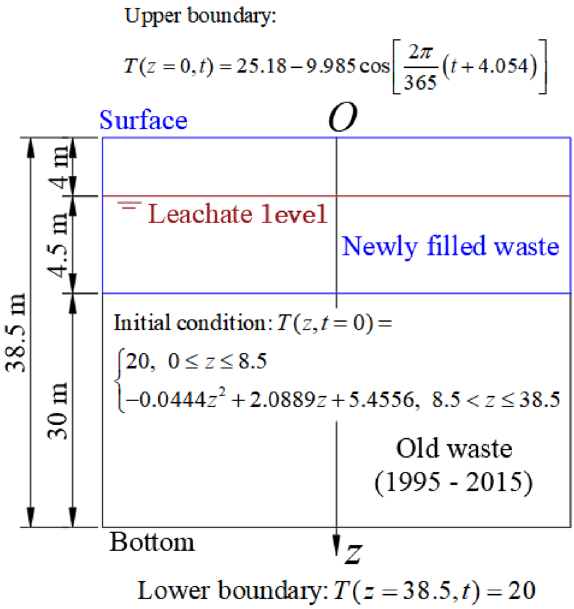
Figure 1. Physical model for heat transfer in the Wuxi